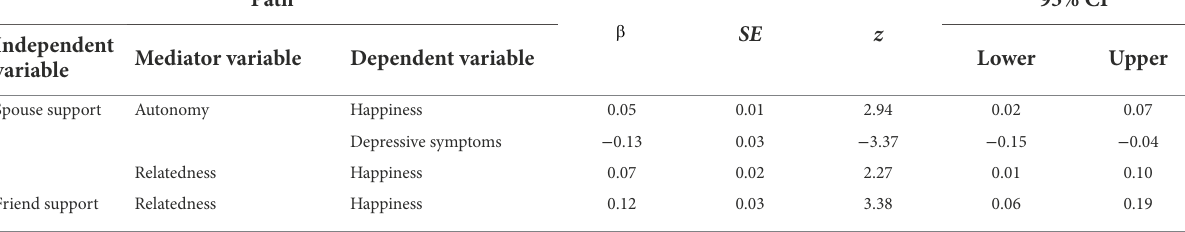
TABLE 4 Bootstrap analyses of the magnitude and statistical significance of indirect